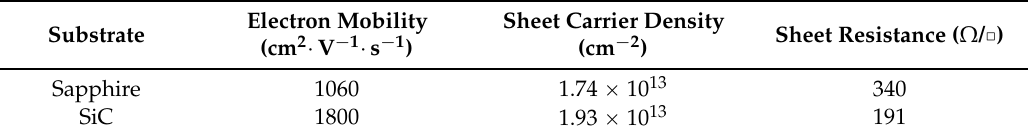
Table 1. Comparison of room temperature 2DEG properties of the Si x N y /InAlGaN/AlN/GaN heterostructures with similar designs grown on sapphire and SiC